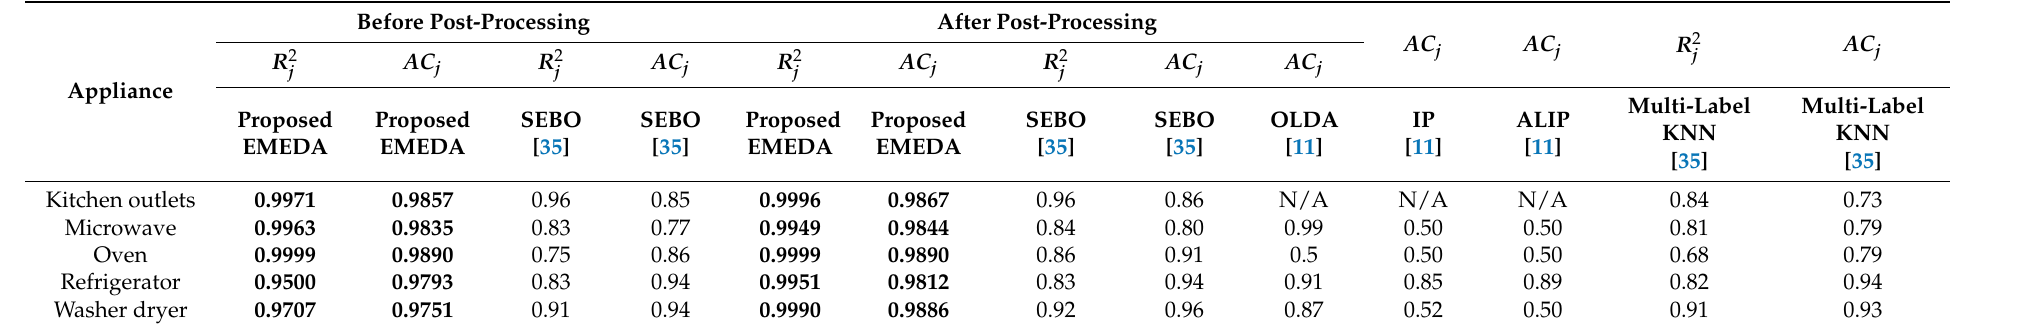
Table 5. Evaluation results of the proposed EMEDA and their comparison with other techniques.